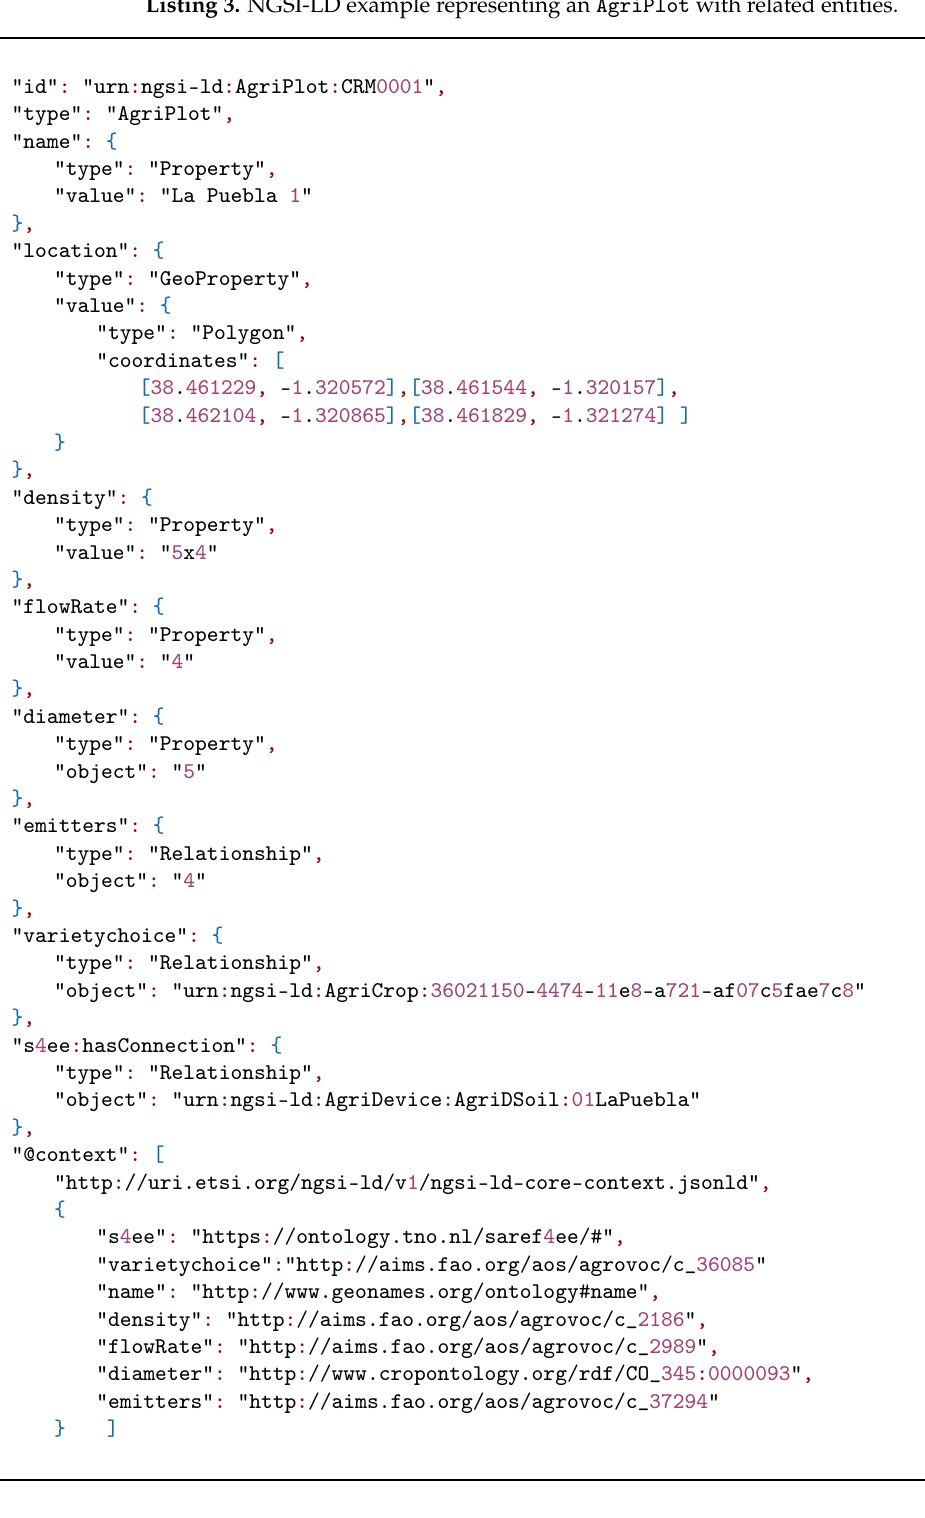
Listing 3. NGSI-LD example representing an AgriPlot with related